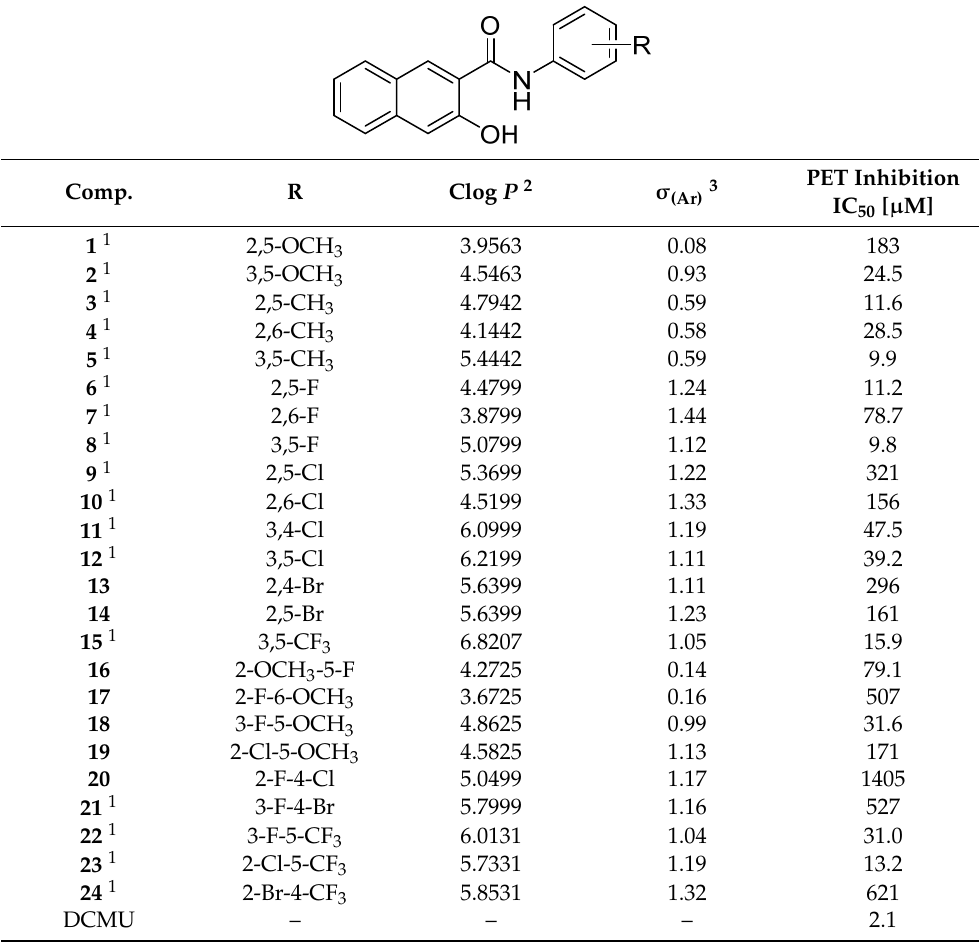
Table 1. Structure of ring-disubstituted 3-hydroxynaphthalene-2-carboxanilides 1 – 24 , calculated values of Clog P for compounds, electronic σ parameters of anilide (Ar) and IC 50 [ µ M] values related to photosynthetic electron transport (PET) inhibition in spinach chloroplasts of tested compounds in comparison with the 3-(3,4-dichlorophenyl)-1,1-dimethylurea (DCMU) standard.